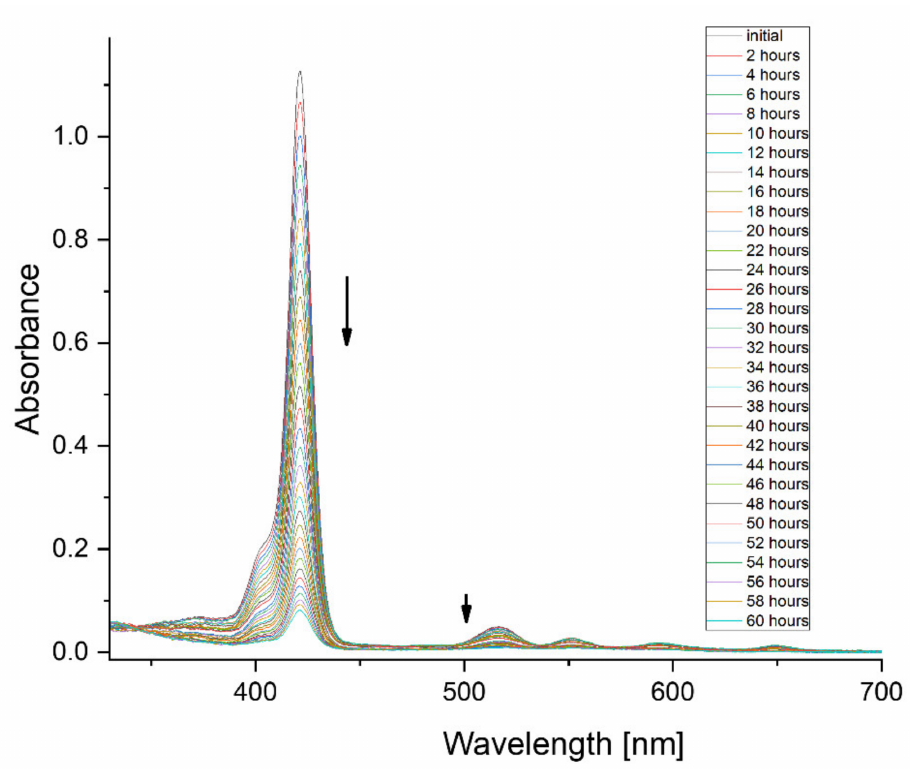
Figure 2. Changes in the absorption of porphyrin 1 observed upon irradiation. The sample was irradiated for 60 h, using an LED emitting at 420 nm (63 mW).